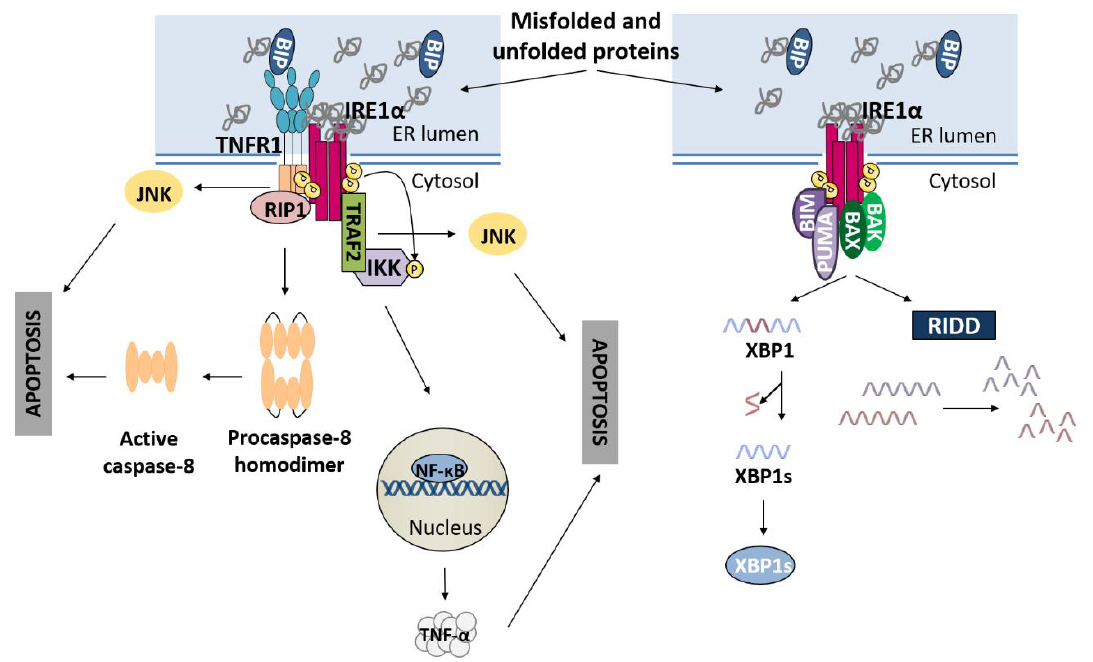
Figure 2. UPRosome platform assembled around IRE1α. Signaling pathways activated following formation of the multi-protein complex named the UPRosome.